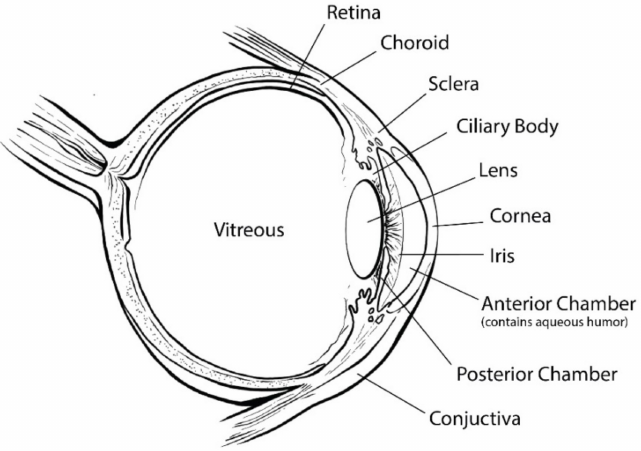
Figure 1. Schematic of the eyeball